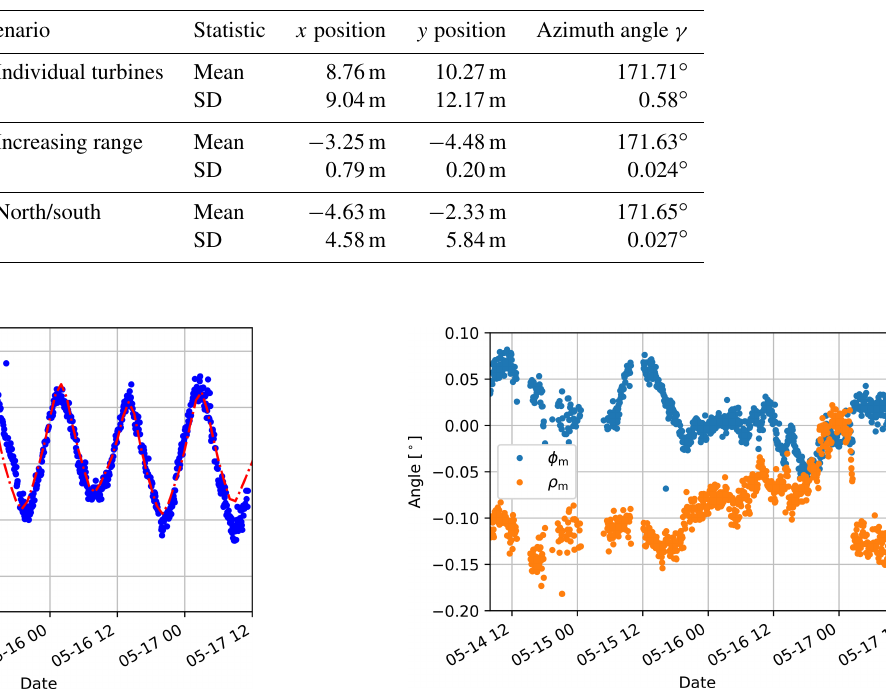
Figure 11. Height above sea level determined during 3d of contin- uous measurements. The blue dots represent the height of the lidar’s scanning head above the sea surface as measured by SSL for a con- tiguous subset of the SSL scan data. Offset-corrected sea surface height from the NEMO model provided by the EU Copernicus Ma- rine Service is shown in red.